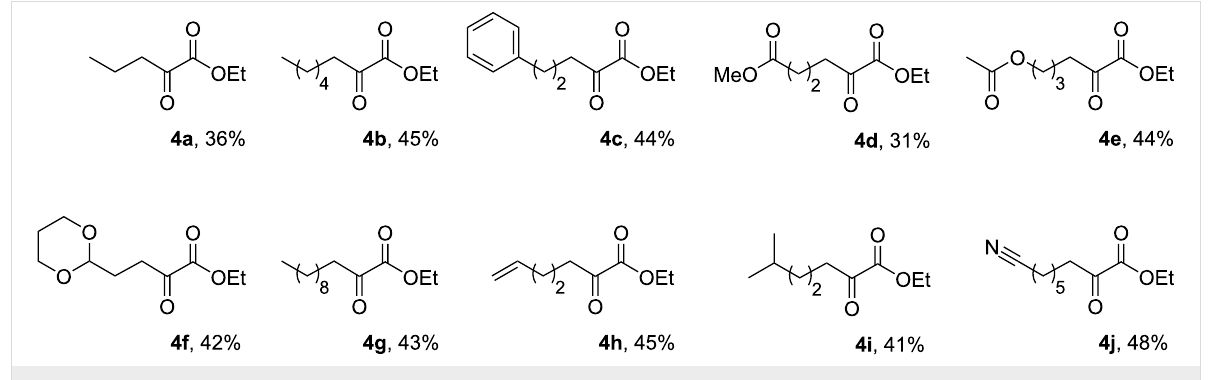
Figure 2: α-Ketoesters prepared and isolated yields.